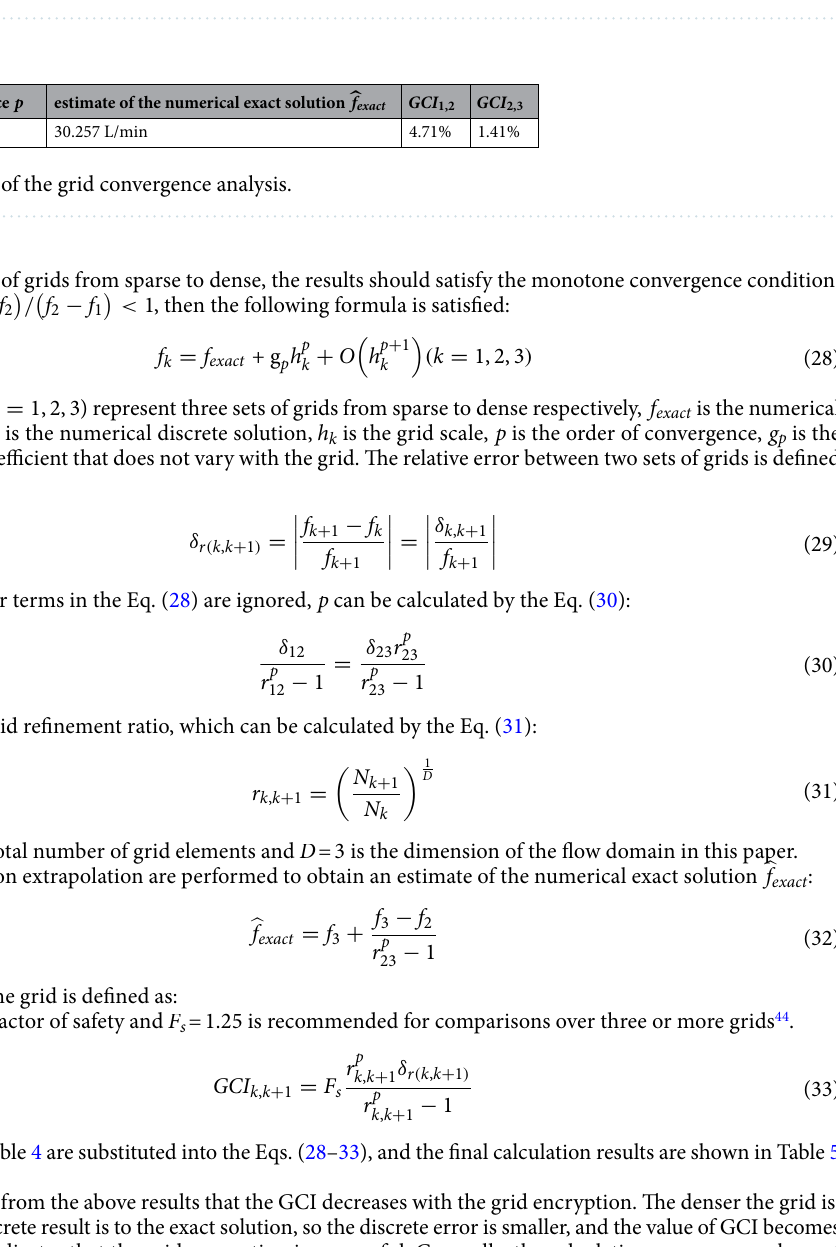
Table 4. Comparison of average flow rate under different grid elements.